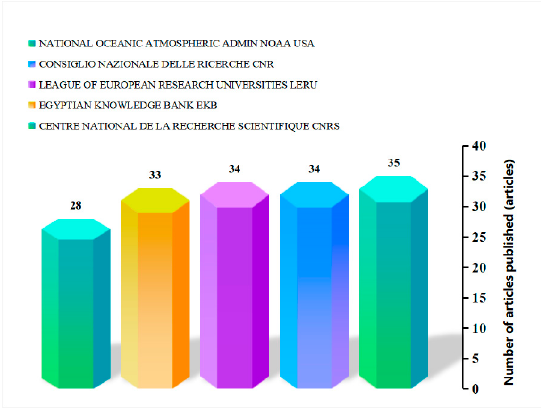
Figure 5. Analysis of the influence of high-yield institutions.